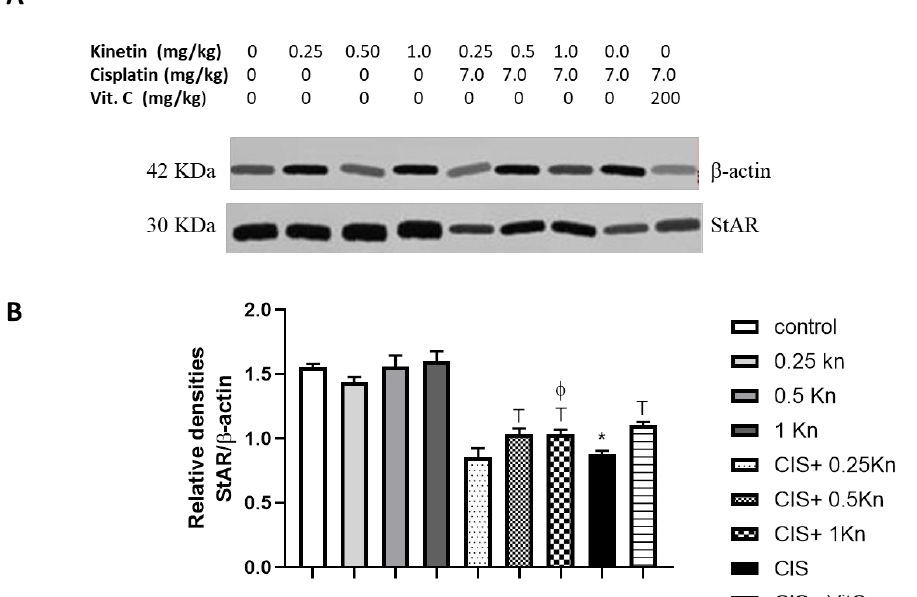
Figure 4. Representative Western blot analysis of StAR protein expression of testicular tissues, showing protein bands of each group ( A ) and graphs presenting their densitometric analysis ( B ). Data are represented as mean ± SEM, *, T, ф and α are significant differences from control, 0.25 Kn, CIS, CIS+ 0.25 Kn and CIS+ 1 Kn groups, respectively, at p < 0.05 where n = 5–6. Kn, kinetin; CIS, cisplatin; VitC, vitamin C.